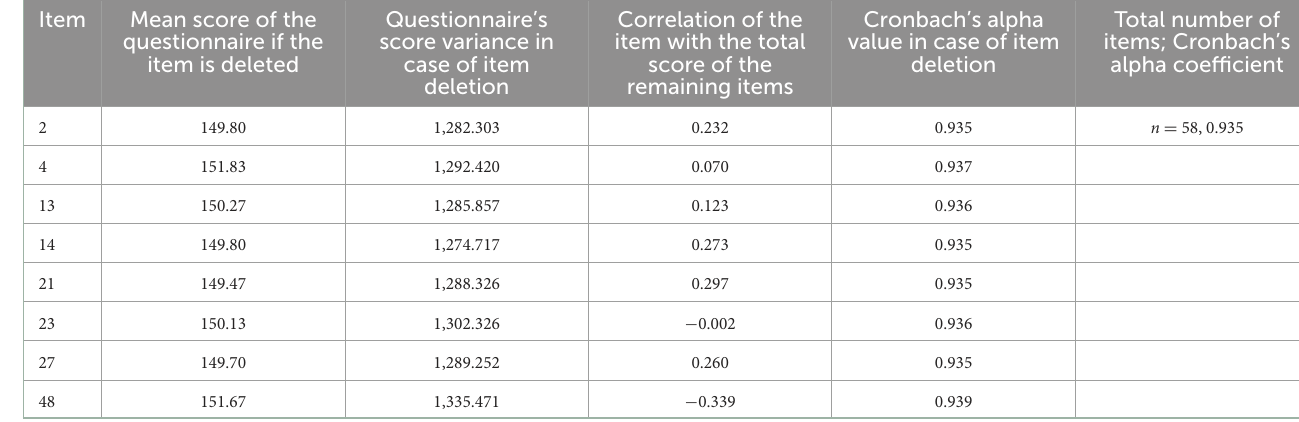
TABLE 2 Item analysis of the